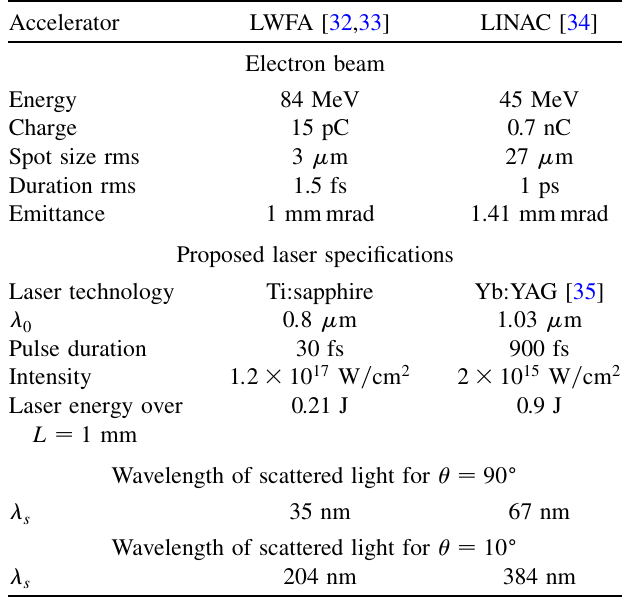
TABLE I. Examples of system parameters.